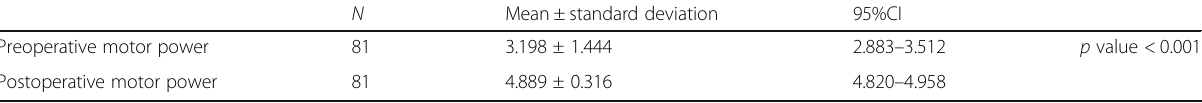
Table 3 The preoperative and the 3-month postoperative values of motor power grades N Mean ± standard